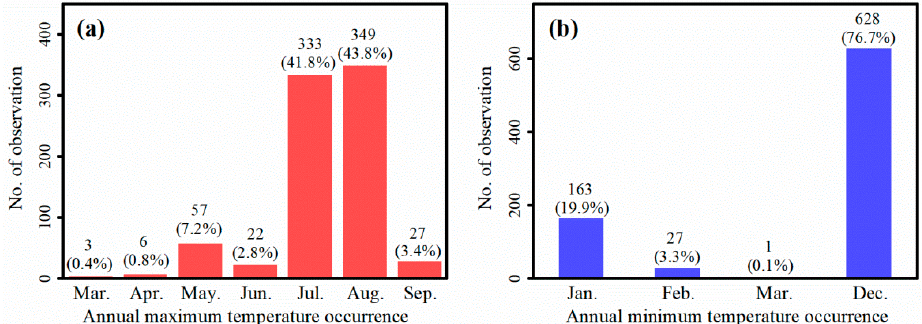
Figure 2. Frequency distributions of ( a ) annual maximum temperature and ( b ) annual minimum temperature occurrence time of 819 meteorological stations from 1981 to 2010 in southern China, where P. massoniana dominate. Data were obtained from meteorological stations in 11 provinces (Guizhou, Chongqing, Guangxi, Hunan, Fujian, Guangdong, Jiangxi, Hubei, Sichuan, Zhejiang and Anhui) provided by China National Meteorological Information Center (http://data.cma.cn/). The percentage of observations are presented in parentheses.